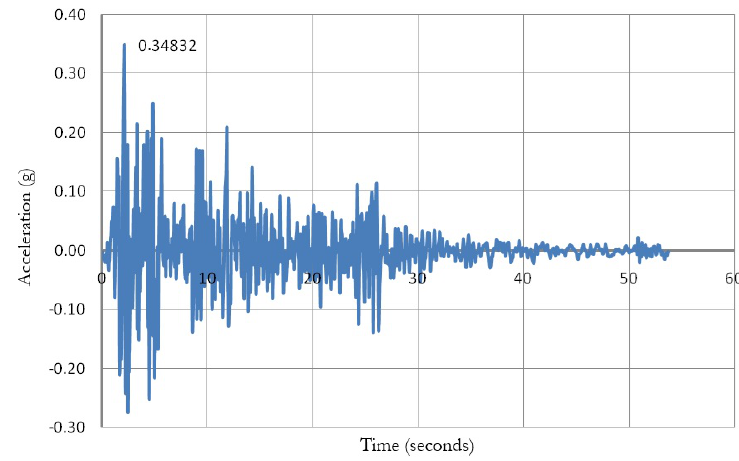
Figure 4. S0E component of the El Centro earthquake